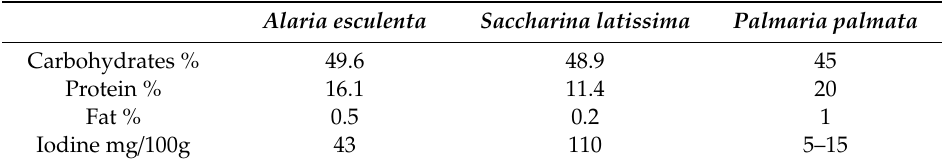
Table 1. The nutritional composition of the three di ff erent pure seaweed varieties.